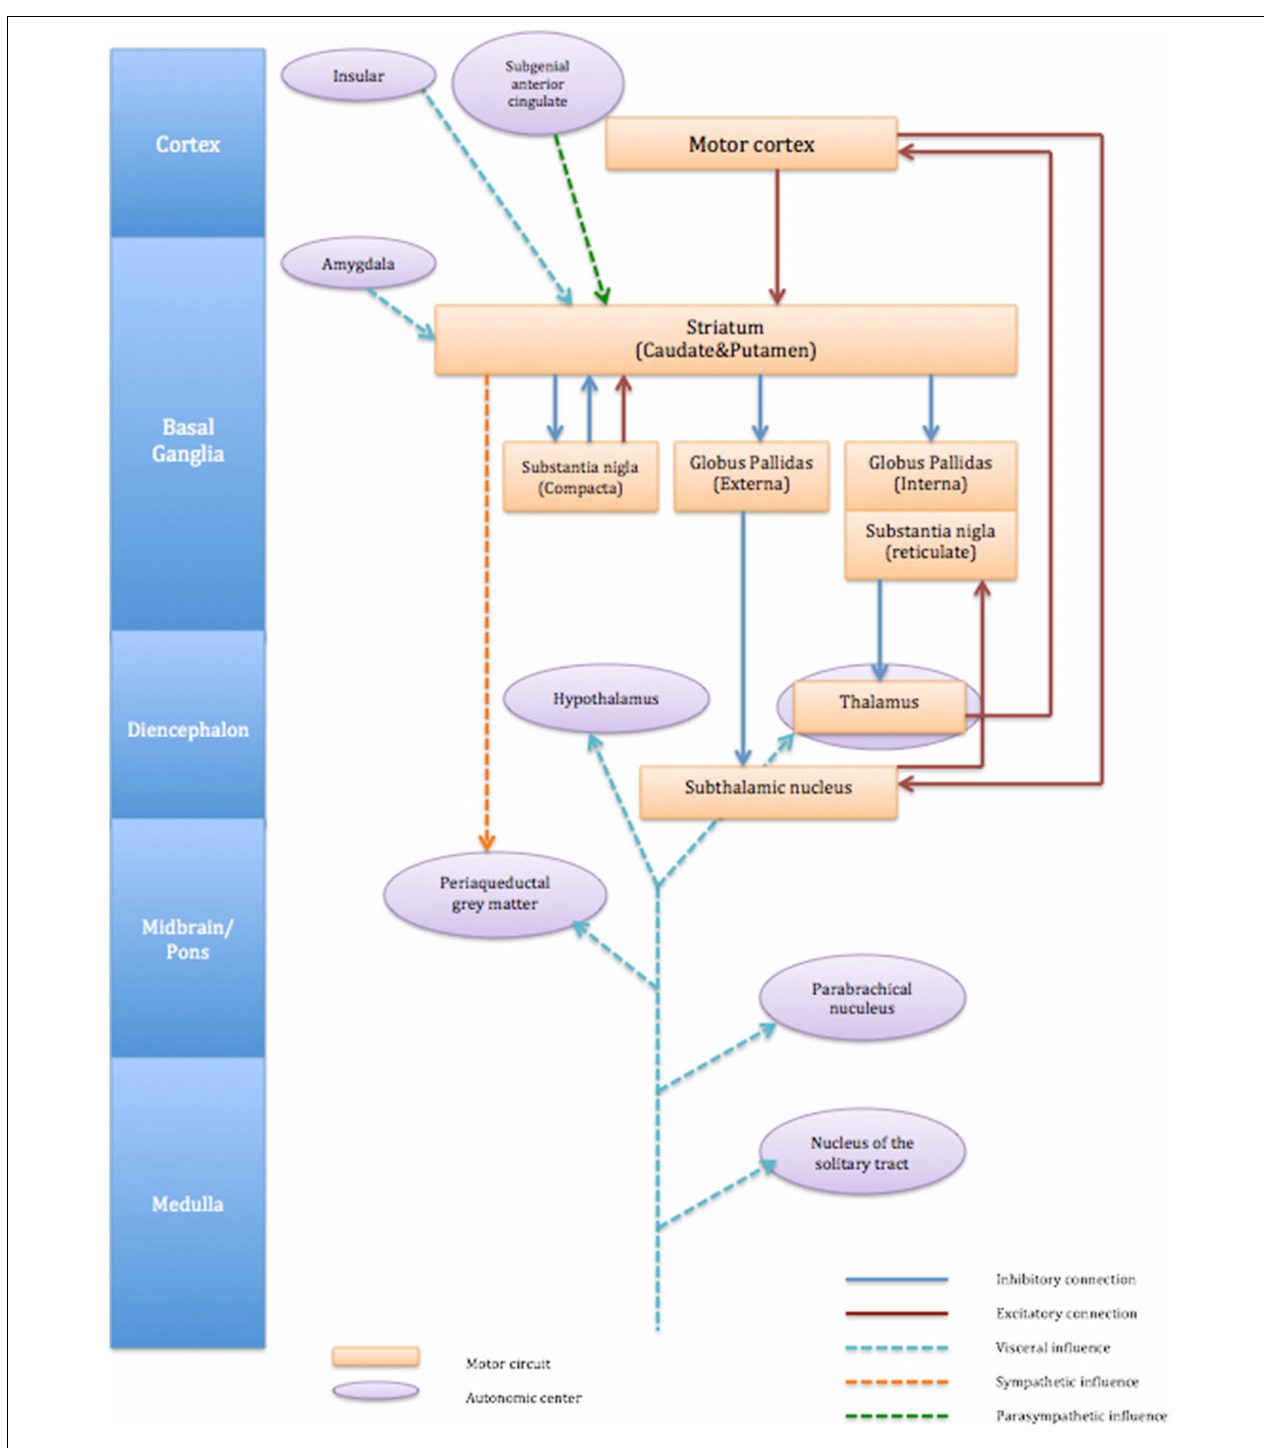
FIGURE 1 | Schematic connection of cortico-striato-thalamo-cortical circuit and associated autonomic centers. The figure describes cortico-striato-thalamo-cortical circuit (orange box) with excitatory connection (red line) and inhibitory connection (blue line). Autonomic centers